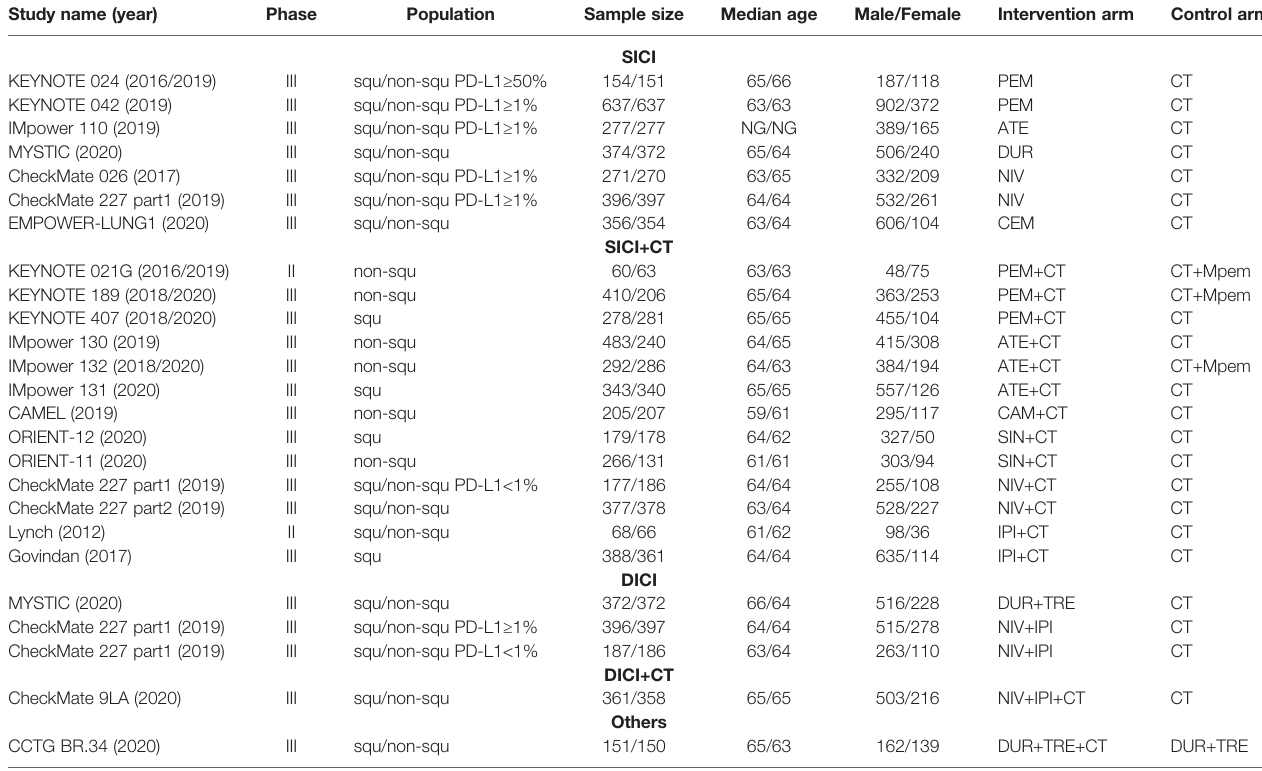
TABLE 1 | Baseline characteristics of studies included in the network meta-analysis of patients with wild-type advanced non-small cell lung cancer. Study name